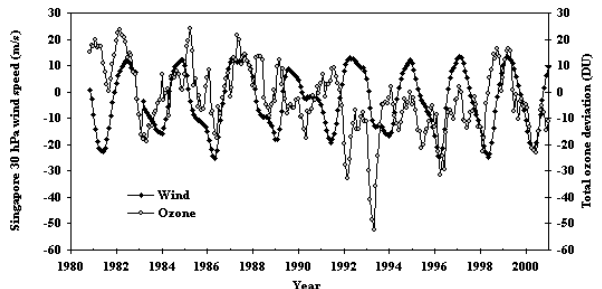
Fig. 6. Covariance of T˜oravere total ozone deviations (DU), lagged by 20 months of the Singapore 30hPa wind speed